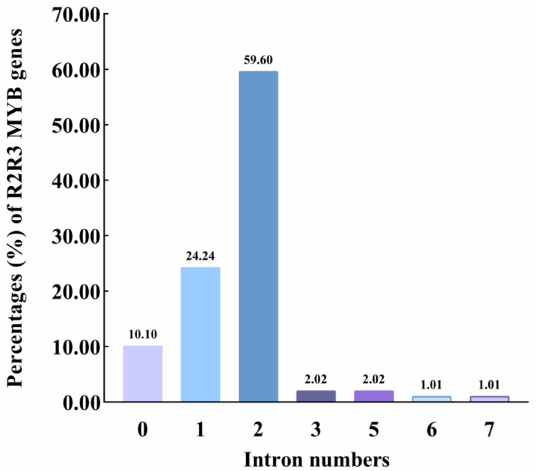
Figure 4. Statistical analysis of the intron numbers of 99 Os2R_MYB genes. The bar chart shows the proportion of Os2R_MYB genes with different intron numbers in the 99 Os2R_MYB genes.